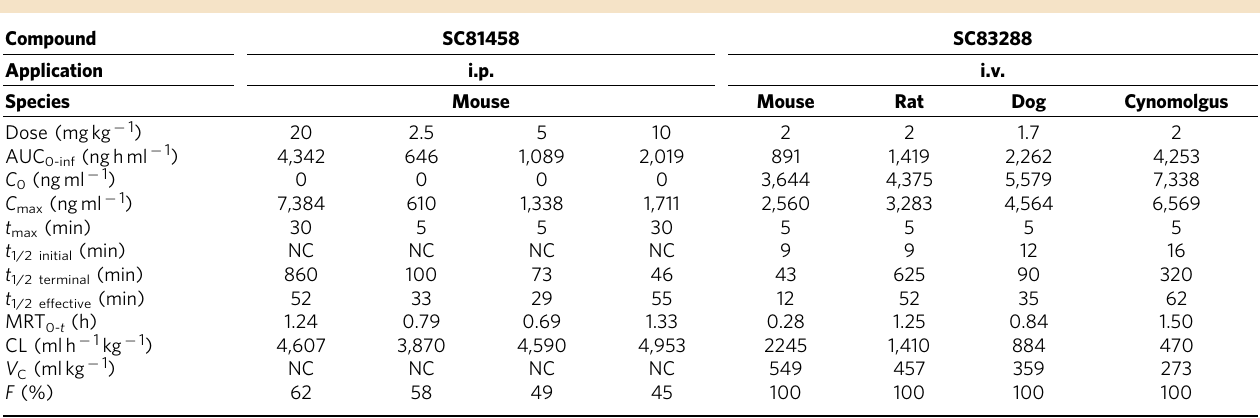
AUC, area under the concentration-time curve; C 0 , initial drug plasma concentration; C max , observed maximum plasma concentration after administration; CL, total plasma clearance of drug after administration; F , relative bioavailability compared to i.v.; MRT, mean residence time of the unchanged drug in the systemic circulation; NC, not calculated; t max , time of C max ; t 1/2 , time required for the concentration to fall to 50% of its initial value; V c , apparent volume of the central or plasma compartment. Data were examined using a non-compartment